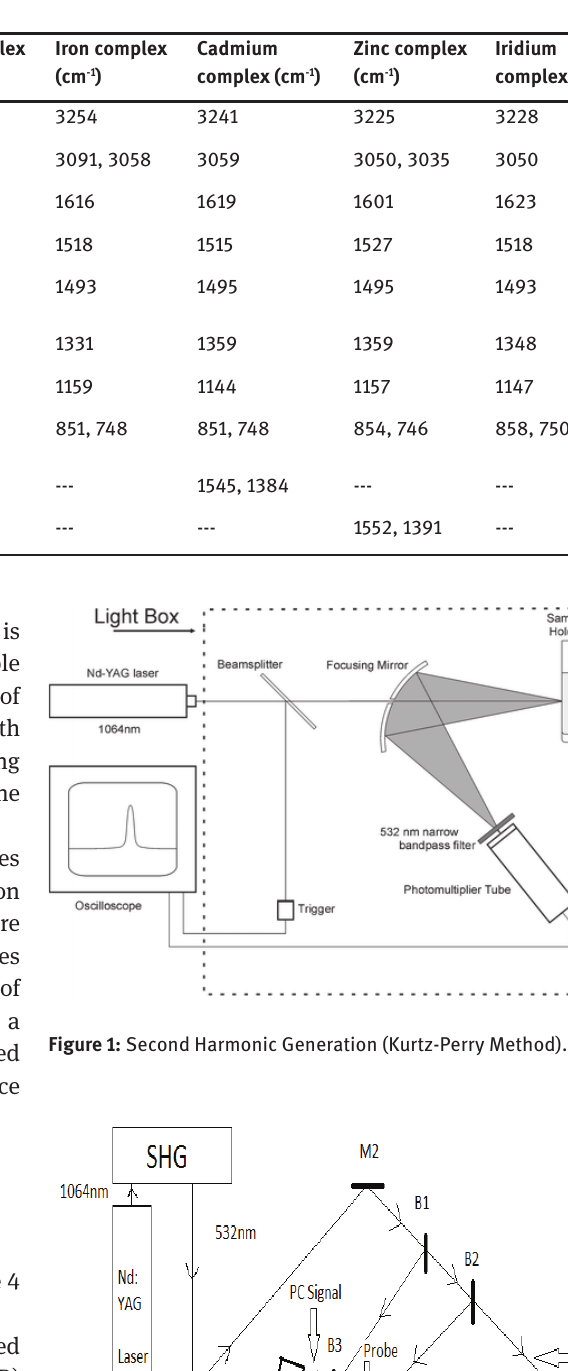
Table 2: IR spectra of the ligand and its complexes.